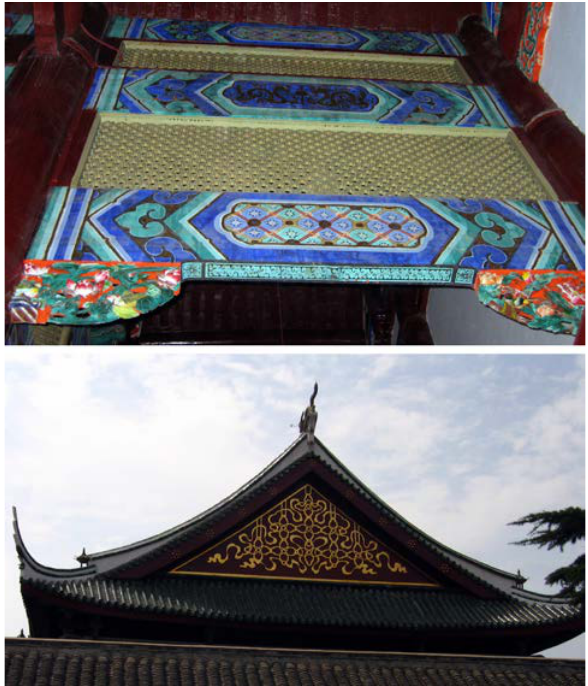
Figure 15. Damages of the conservation on the Great